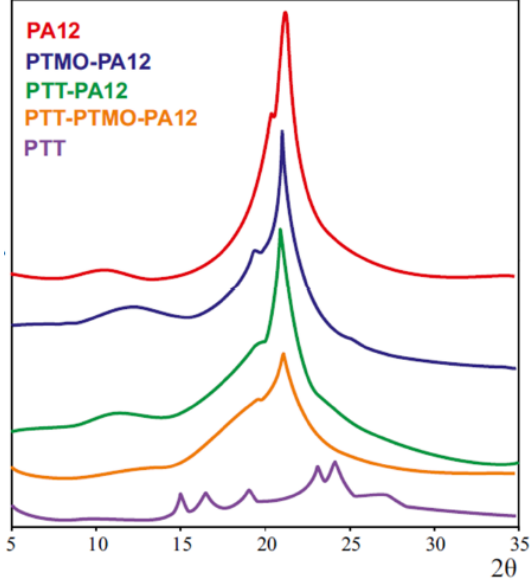
Figure 8. Wide Angle X-ray (WAXS) diffractograms of homo- and copolymers. For the PTT homopolymer, six extreme peaks with the values of 2 Θ reflections 15.08°, ◦ , 19.17 ◦ , 23.19 ◦ , 24.39 ◦ and 26.91 ◦ can be observed. The diffractogram of the PA12 16.51°, 19.17°, 23.19°, 24.39° and 26.91° can be observed. The diffractogram of the PA12 16.51